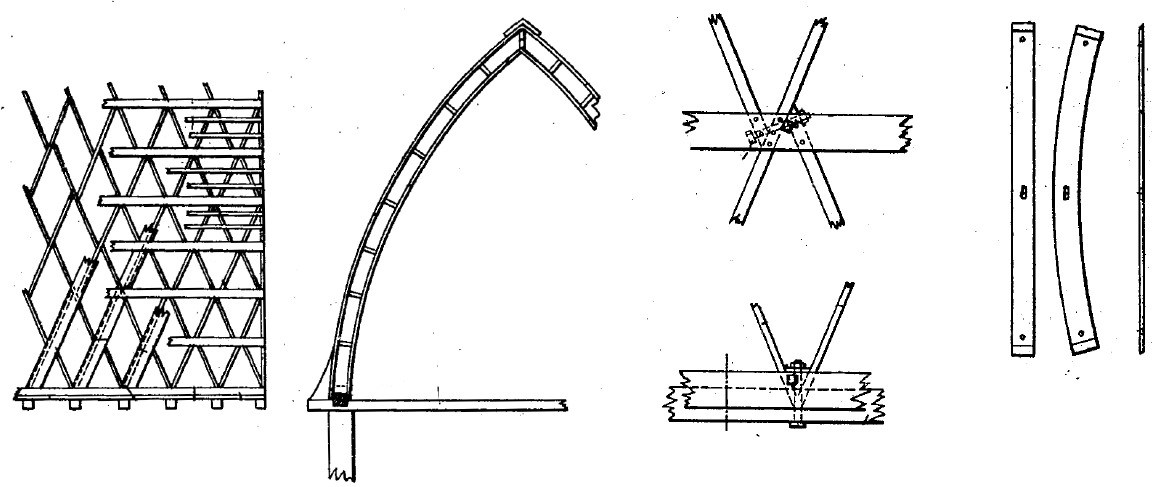
Figure 1. Friedrich Zollinger’s patent for a lamella roof shows the elements of the roof, its geometry, joints, and lamella shape [11].